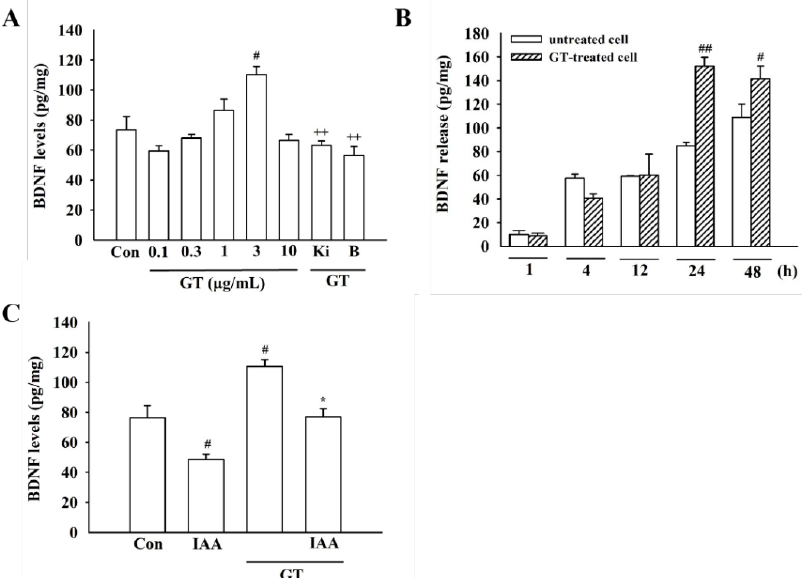
Figure 4. Effect of gintonin on the amount of BDNF release under IAA insult in HT22 cells. ( A ) The levels of BDNF released from HT22 cells treated with the indicated concentrations (0.1–10 µ g/mL) of gintonin for 24 h or with gintonin (3 µ g/mL) in the presence of Ki16425 (Ki) (10 µ M, 30 min) and BAPTA-AM (50 µ M, 30 min). ( B ) HT22 cells were exposed to 3 µ g/mL gintonin at various times (1, 4, 12, 24, and 48 h). ( C ) Effects of gintonin (3 µ g/mL, 24 h) on BDNF release in the presence of IAA (5 µ M, 2 h). The data are represented as the mean ± standard error of the mean (SEM; n = 4). # p < 0.05 and ## p < 0.01 compared to control group; * p < 0.05 compared to IAA-treated group; ++ p < 0.01 compared to the gintonin-treated